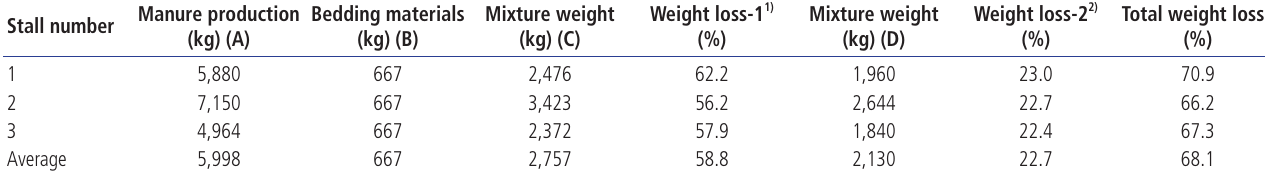
Table 3. Experimental weight reduction of dairy cattle manure in dairy cattle barn and composting lot after 4 months Manure production Bedding materials Mixture weight Stall number (kg) (A) (kg) (B) (kg) (C)